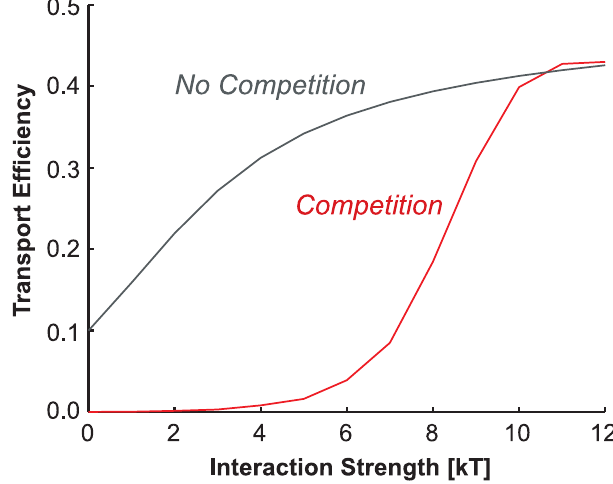
Figure 4. Karyopherins Efficiently Exclude Nonspecifically Binding Macromolecules from the NPC Shown is the transport efficiency of particles across the NPC as a function of interaction strength with the FG-repeat regions, either in the presence or absence of competing particles. Gray line: transport efficiency of particles as a function of interaction strength in the absence of competition. Red line: transport efficiency of a weakly binding species in an equal mixture of weakly and strongly binding species, as a function of the interaction strength of the weakly binding species; the interaction strength for the strongly binding species is 12k B T. Translocation of the weakly binding species is sharply reduced in the presence of the strongly binding species, until its binding strength approaches that of the strongly binding species. No RanGTP activity was included in these simulations, hence lowering the transport efficiency compared with Figure 3.